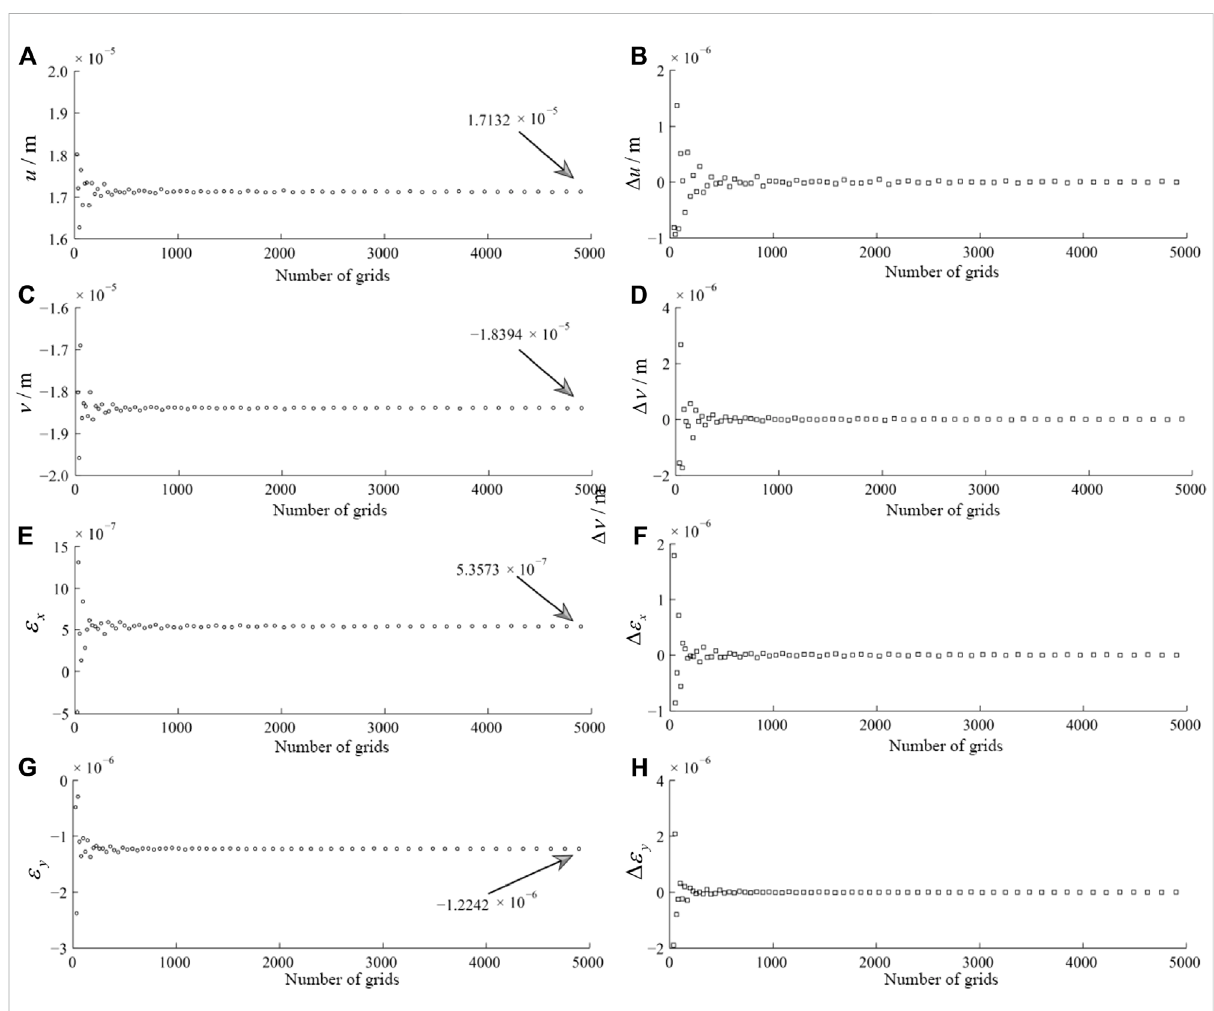
FIGURE 8 The relationship between the horizontal displacement and linear strain and the change of number of grids n in the point of M(1.5 m, − 1.5 m, − 0.1 m) using themodel of three dimensional irregular load (A) the relationshipbetweendisplacement uand number of grids n; (C) the relationship between displacement v and number of grids n; (E) the relationship between linear strain ε x and number of grids n; (G) the relationship between linear strain ε y and number of grids n; (B) , (D) , (F) , (H) are the fi rst-order differences of data of (A) , (C) , (E) , (G)